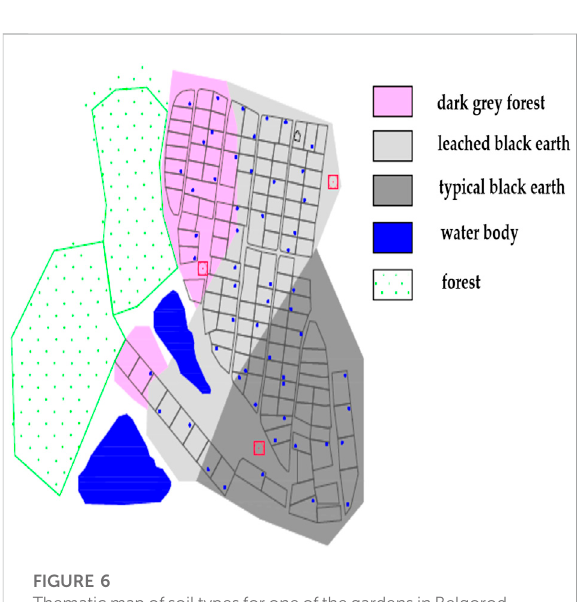
FIGURE 6 ThematicmapofsoiltypesforoneofthegardensinBelgorod municipal